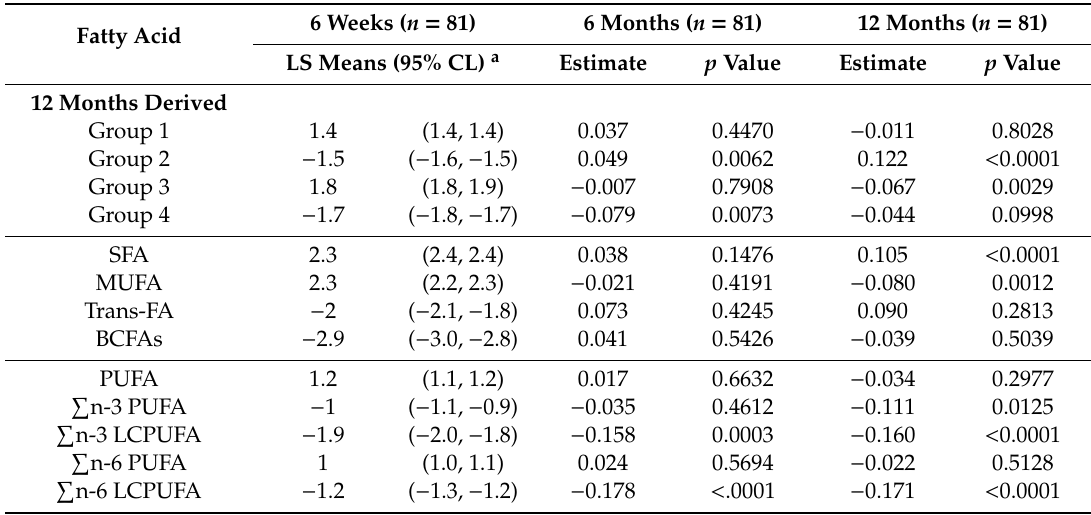
Table 3. Changes in human milk fatty acid composition during the first year of